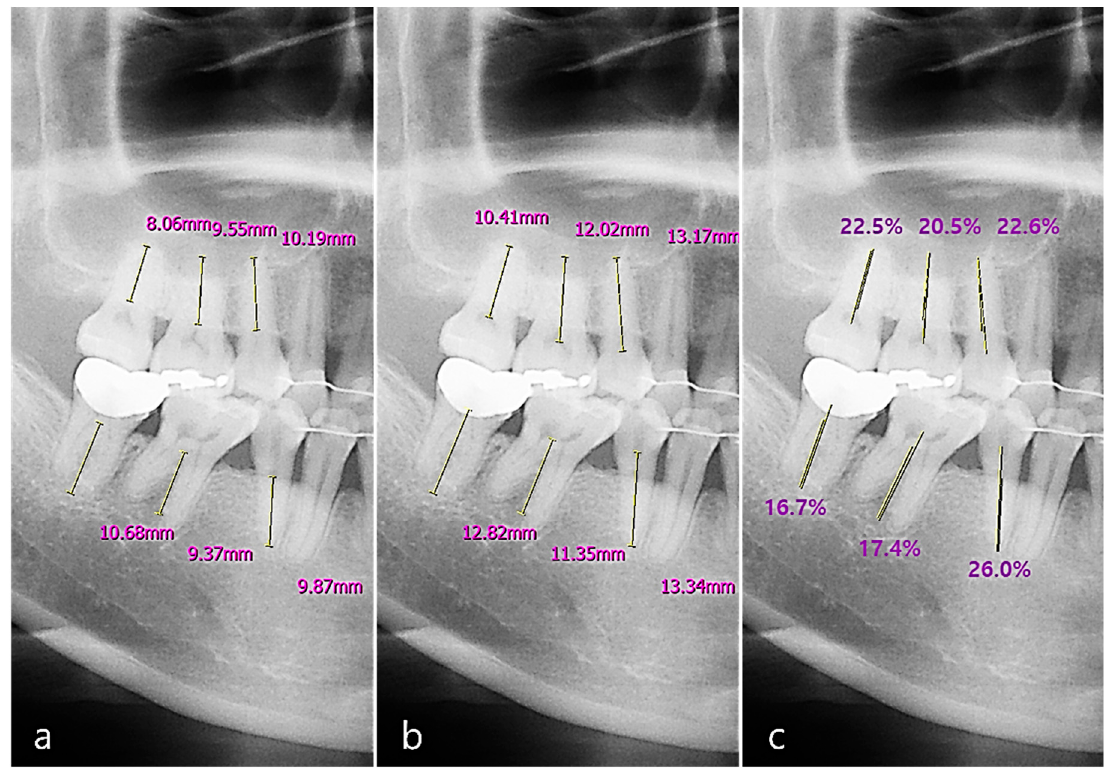
Figure 5. The measurement of RBL (radiographic bone loss) on a panoramic image: ( a ) the distance from the root tip of the tooth to the periodontal bone level (PBL); ( b ) the distance from the root tip of the tooth to the cementoenamel junction level (CEJL); ( c ) the percentage rate of the intersection length of the PBL and the other CEJL.